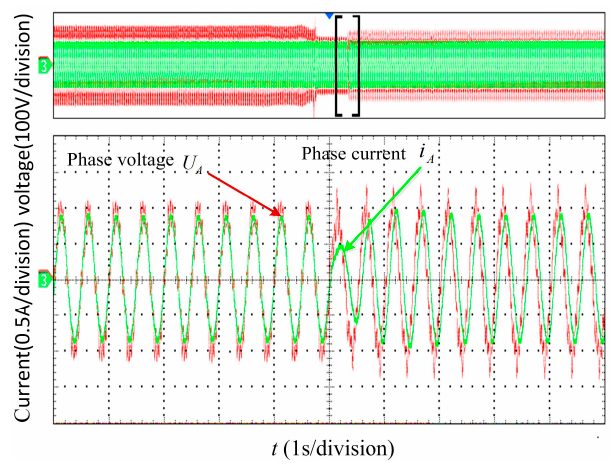
Figure 18. Experimental results to provide voltage support.